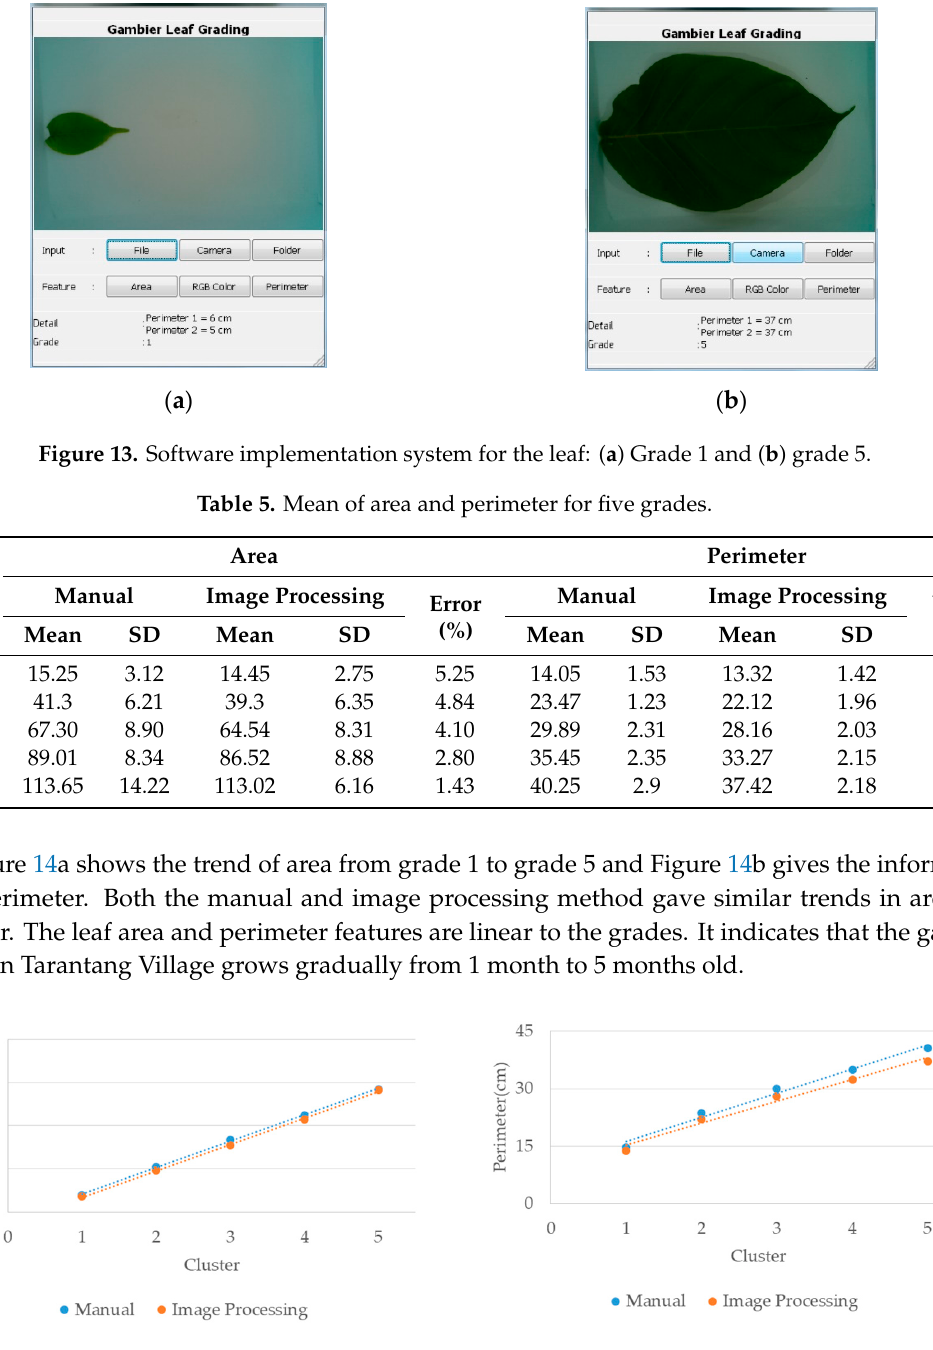
Figure 14. Feature pattern for ( a ) area feature and ( b ) perimeter feature.